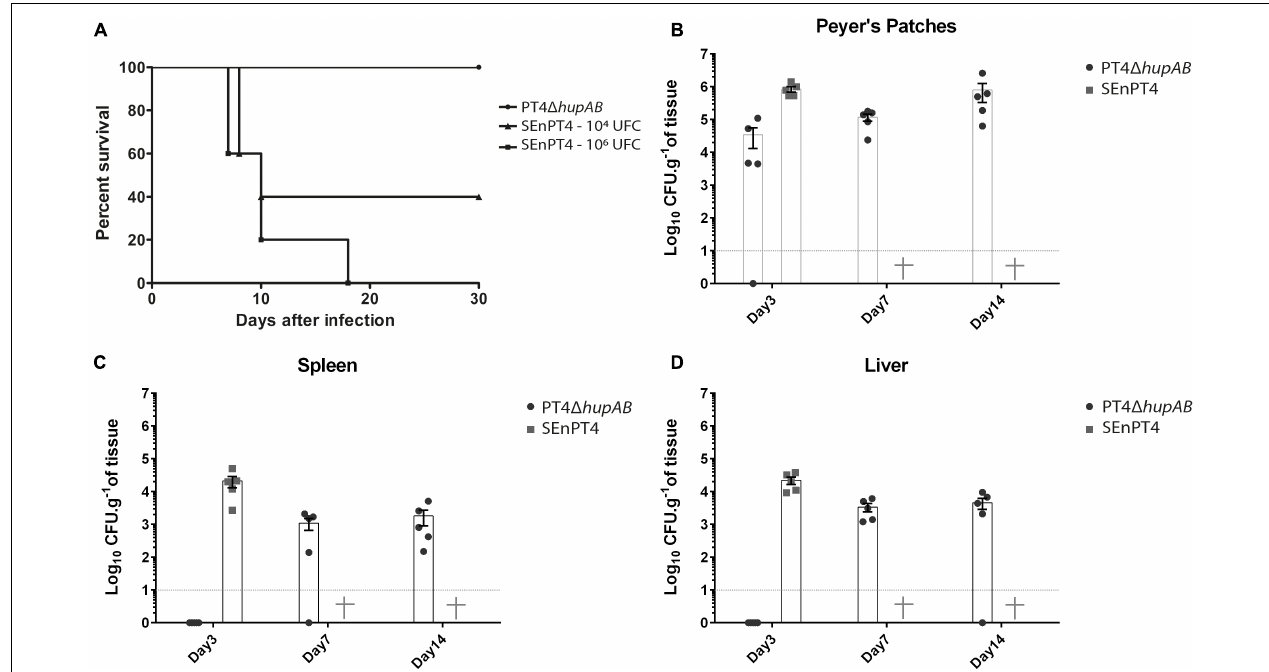
FIGURE 2 | Bacterial cell counting in BALB/c mice organs and attenuation assay following oral inoculation with PT4 (cid:49) hupAB . (A) Mice were orally inoculated with 1 × 10 4 or 1 × 10 6 CFU of SEnPT4 to evaluate the virulence of the parental strain; another group was inoculated with 2 × 10 9 CFU of PT4 (cid:49) hupAB that exhibited attenuation. Peyer’s patches (B) , spleen (C) , and liver (D) were collected from five animals at 3, 7, or 14 days after inoculation, homogenized in PBS, and plated onto MacConkey’s agar for bacterial counting. Data are representative of two experiments with similar results, and the values are represented by mean ± SD. Some colonies were randomly chosen for PCR confirmation (data not